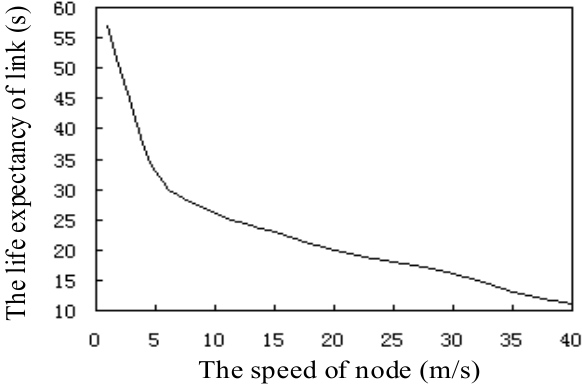
Figure 10. Relationship between the expected life and velocity of the node link ( a = 0 m/s, b = 40 m/s, R = 250 m).